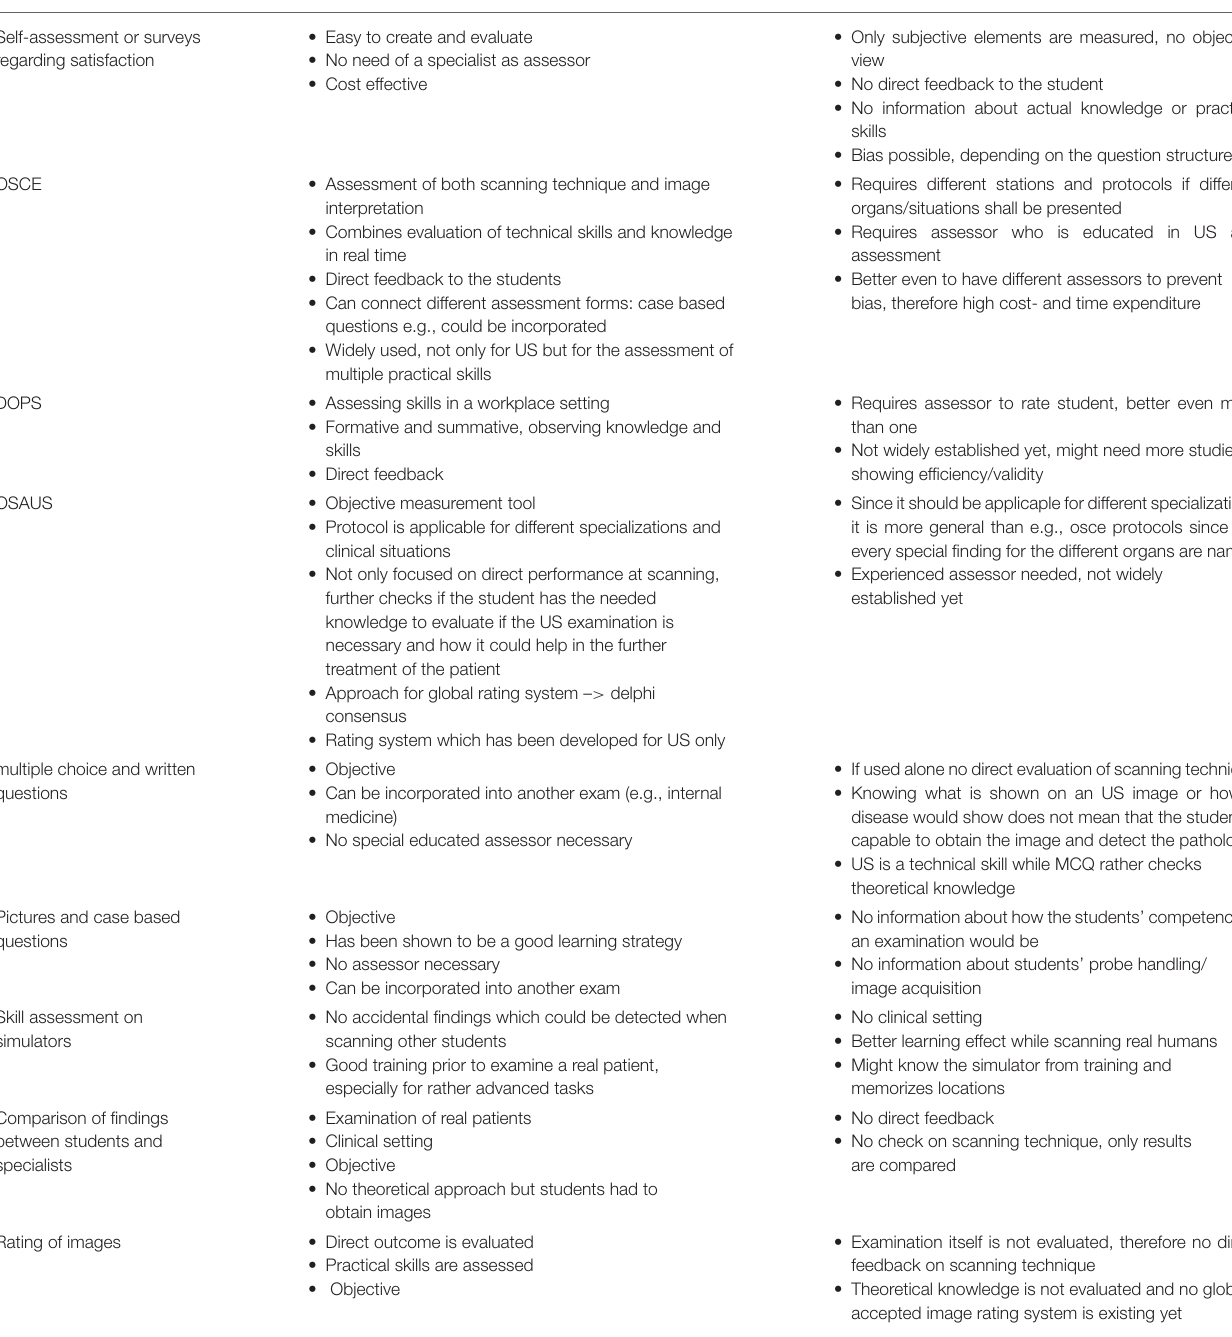
TABLE 3 | Ultrasound assessments in medical